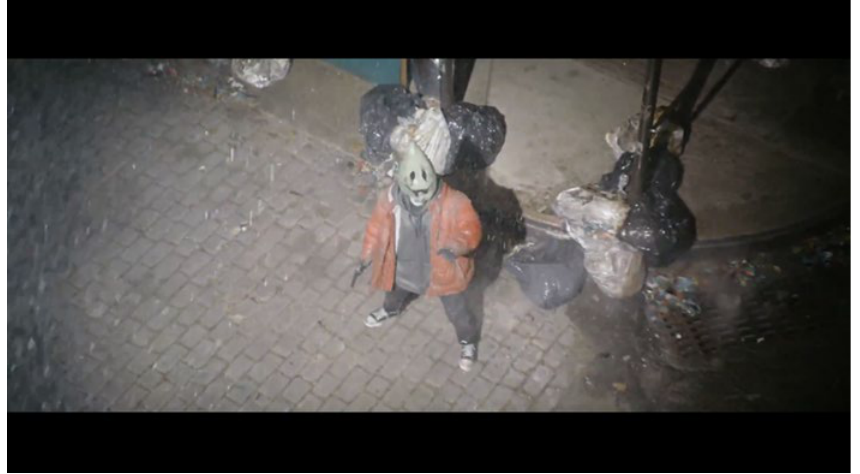
Figure 2 Thieves see the Batman